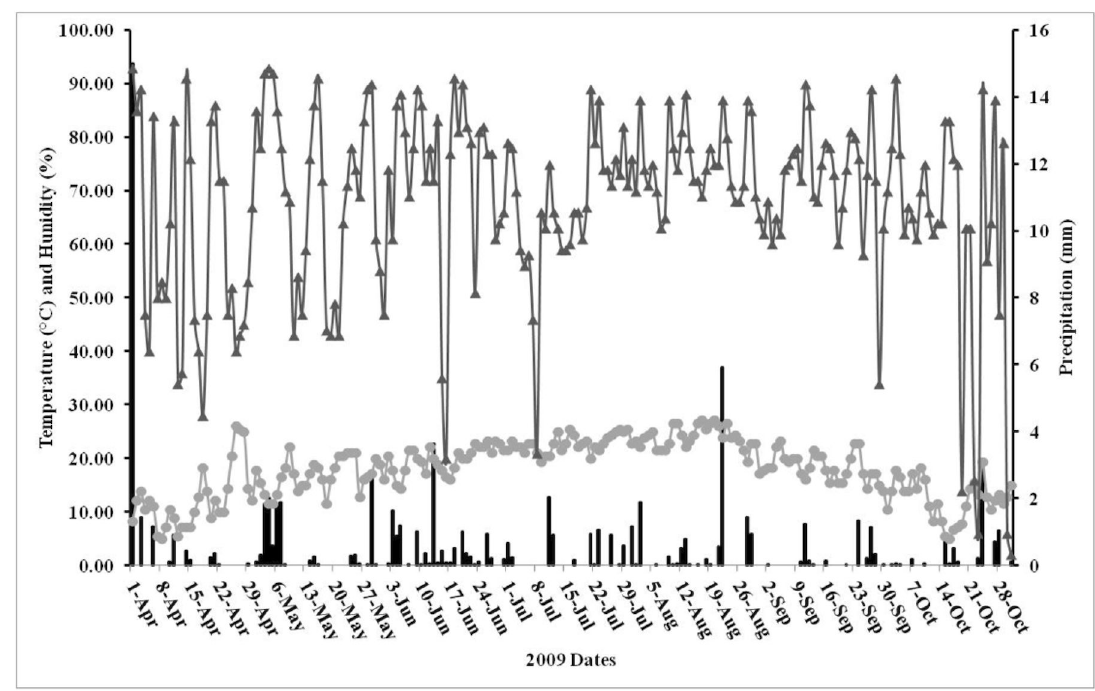
Figure 3. Daily temperature, humidity, and rainfall data from the Trenton weather station (Mercer-Trenton Airport, TTN) during the 2009 mosquito season. Gray line with circles: temperature, dark grey line with arrows: humidity, black columns: precipitation. doi: